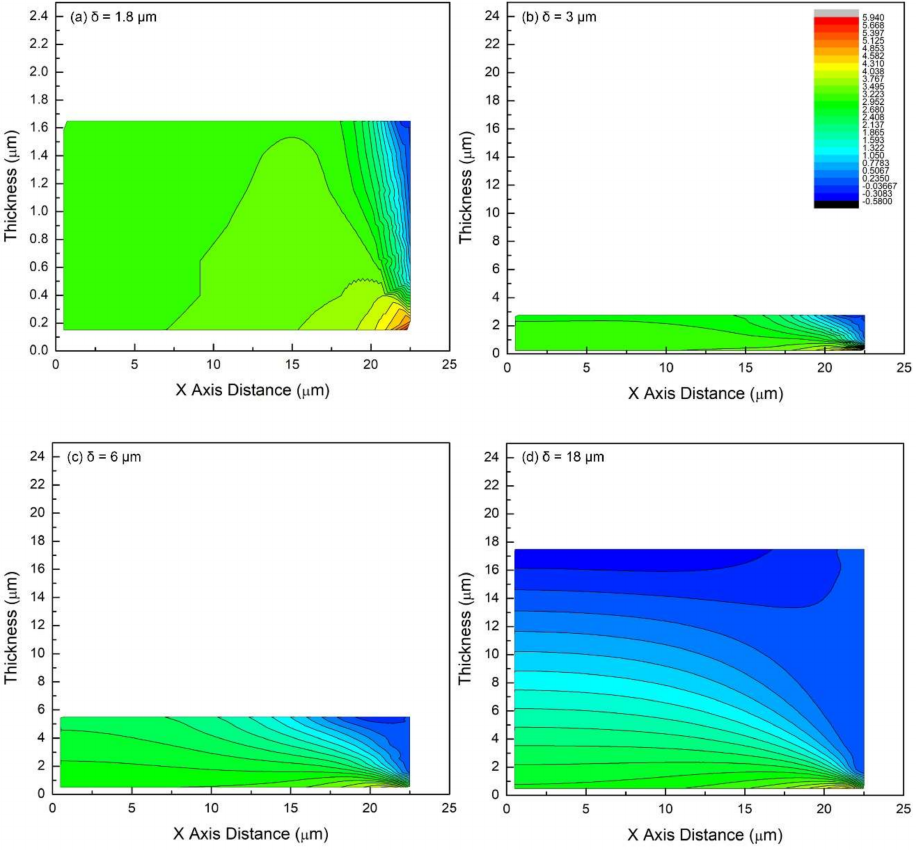
Figure 3. The in-plane stress distribution (two-dimensional (2D)-contour plot) in films of different thicknesses for the case of the film/substrate system being tested in tension: ( a ) δ = 1.8 µ m, ( b ) δ = 3 µ m, Note that the y-axis scale is different for the thinnest coating to clearly illustrate the difference in the stress distribution of thin coatings as compared to thick